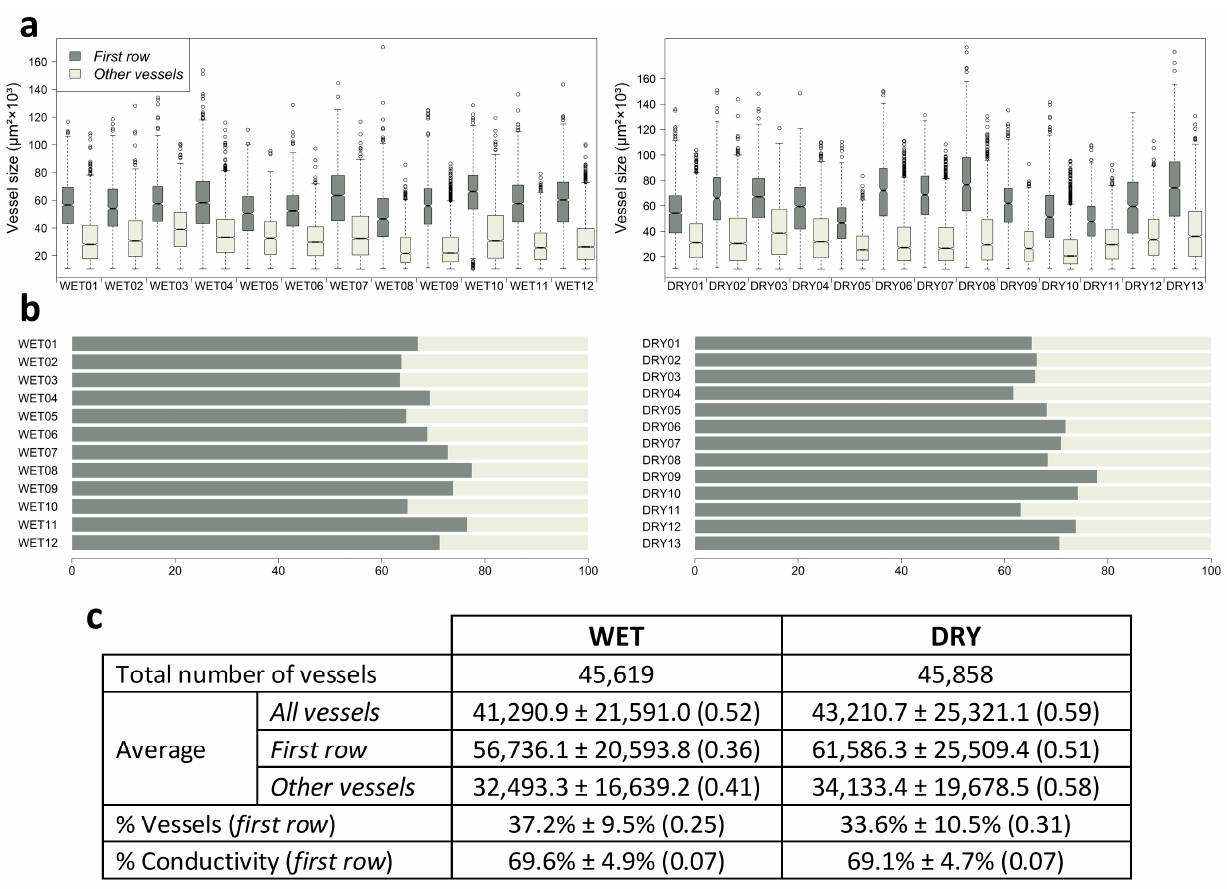
Figure 1. Boxplots of vessel size distribution (area in µm 2 ) at each site ( a ), percentage of conductivity carried out by the first row or other vessels ( b ), and descriptive statistics (mean ± standard deviation) ( c ); values in brackets represent the coefficient of variation. Tree codes are numbered correlatively according to their site (WET or DRY).